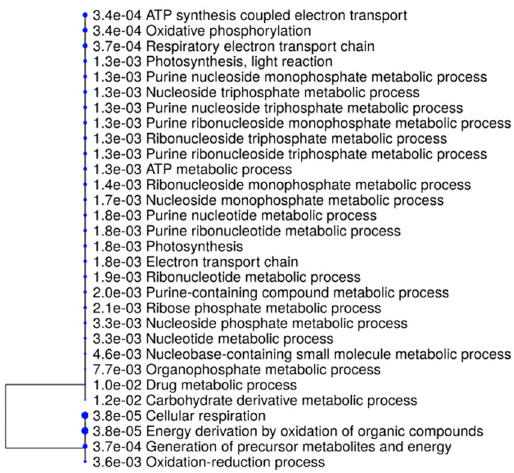
Figure 6. A hierarchical clustering tree. Pathways with many shared genes are clustered together. Larger dots indicate more significant p -values.